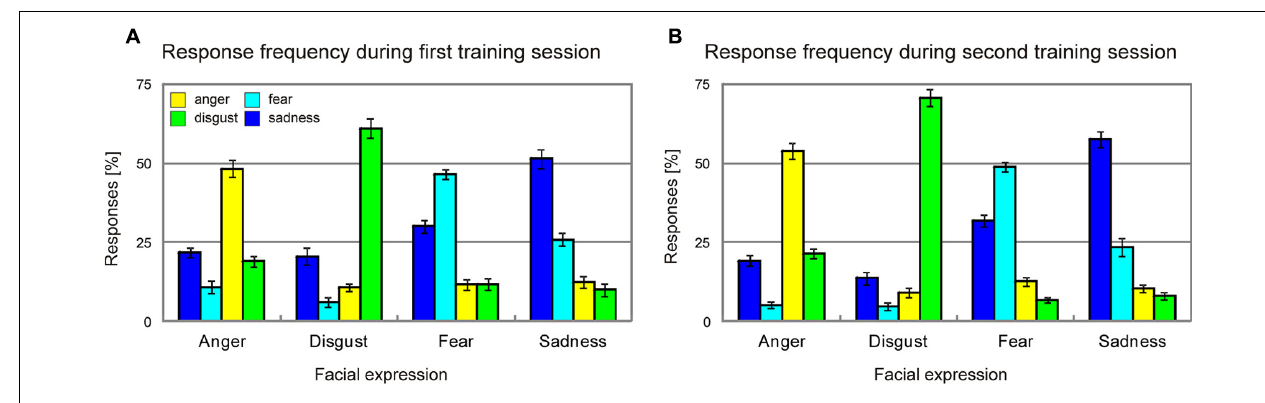
session to the first block of the second training session for long, but not for short videos (dark/bright dashed red lines in A , dark/bright bar charts in B ). Dark/bright gray filled circles in A represent block averages for long/short videos across all participants. Numbers on the y-axis indicate percentage of correctly recognized facial expressions (note that chance level is 25%). Error bars indicate SEM. Asterisks indicate significant effects ( p < 0.05).